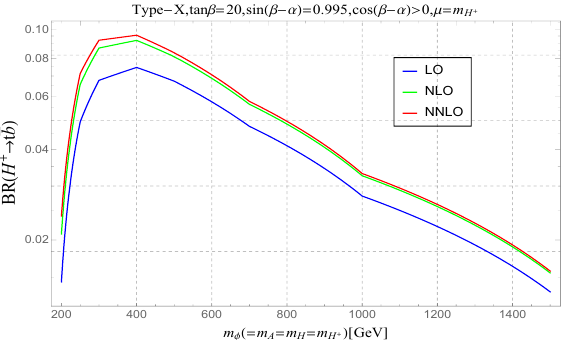
Figure 8. Branching ratio of the charged Higgs boson decay into t ¯ b in the 2HDM of Type-X, using the LO(Blue), NLO(Green) and NNLO(Red) partial width with tan β = 20 , sin( β − α ) = 0 . 995 and cos( β − α ) > 0